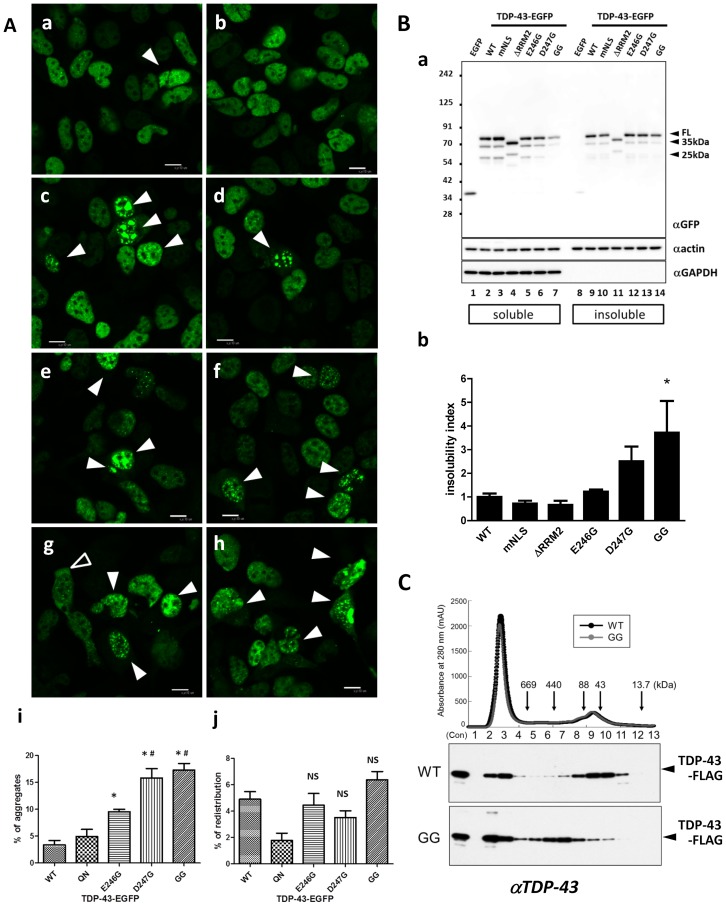
Substitution mutants of full-length TDP-43 at E246 and D247 are readily misfolded.
A. Confocal micrographs of HEK293A cells overexpressing EGFP-fused full-length TDP-43 (a, b, wild-type (WT), c, d, E246G, e, f, D247G, g, h, E246G/D247G). i, j, Percentages of transfected HEK293A cells harboring multiple puncta or inclusions (i, arrowheads) or displaying nucleus-excluded TDP-43 (unfilled arrowhead). (j). Scale bar indicates 30 µm. Data were expressed as the mean ± SEM (N = 7–10). *p<0.05 vs. WT, #p<0.05 vs. E246G by one-way ANOVA with Newman-Keuls test. NS indicates not significant vs. WT. B. a, Western blotting showing the increased detergent-insolubility of TDP-43 with mutations at E246/D247, with defective nucleus localizing signal (mNLS), or devoid of RRM2 domain (ΔRRM2). Lysates from HEK293A cells transiently transfected with TDP-43-EGFP were separated into 1% TritonX100-soluble or -insoluble fractions. Top panel, anti-GFP; middle panel, anti-actin; bottom panel, anti-GAPDH. The GAPDH blot validates the successful separation between detergent-soluble and -insoluble components. b, Quantified insolubility of TDP-43-EGFP proteins with or without mutation at E246/D247 to glycine. Relative TDP-43-EGFP in the detergent-soluble or -insoluble fraction was obtained from the ratio of the GFP density to actin density from the densitometric value in each fraction (designated as insoluble TDP or soluble TDP, respectively). Insolubility index was obtained from the ratio of insoluble TDP to soluble TDP, and each value was standardized by the average ratio of WT. Data were expressed as the mean ± SEM of four experiments.*p<0.05 vs. WT TDP-43-EGFP by one-way ANOVA with Newman-Keuls test. C. Size exclusion chromatography and Western blotting indicating the existence of oligomeric and monomeric states of full-length TDP-43 in cells. WT and E246G/D247G (GG) TDP-43-FLAG genes were expressed in HEK293A cells. Cells were sonicated in PBS, and the supernatants were fractionated by a Superose 12 column (10/300) at a flow rate of 0.5 mL/min in PBS. Fractionated cell extracts were applied to Western blotting by anti-TDP-43 (Proteintech). Mutant TDP-43 (GG) proteins were collected in a larger fraction than 88–440 kDa. The molecular size markers thyroglobulin (669 kDa), ferritin (440 kDa), Mn-SOD (88 kDa), ovalbumin (43 kDa), and RNase (13.7 kDa) were eluted under the same conditions. Abs280 is presented to show the equal amount of proteins between WT and the GG mutant in each fraction.